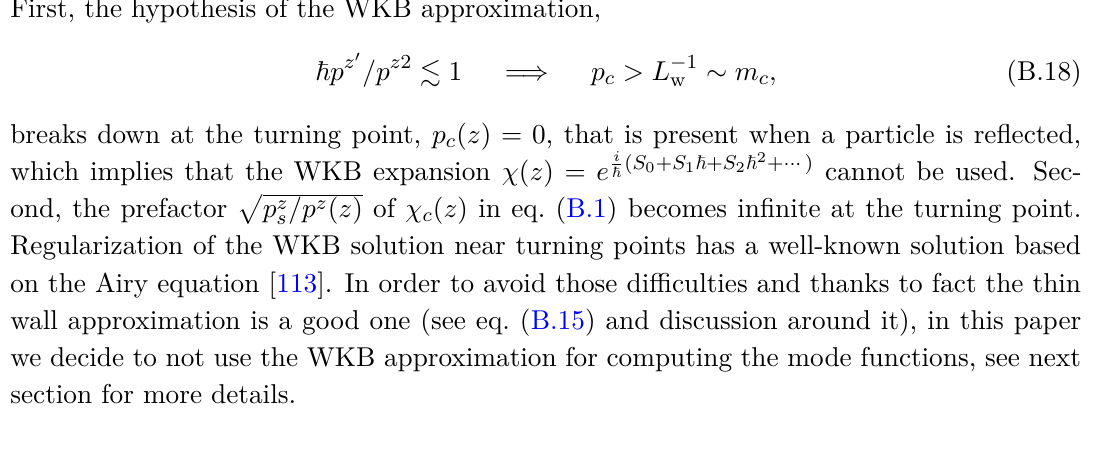
Figure 10 . The exchanged momentum h ∆ p i becomes first logarithmically suppressed when the wall thickness satisfies L w & m − 1 and then exponentially suppressed around L w ∼ m c,h /m 2 c,h lines show the numerically integrated result in eq. (B.13) while dashed lines show the analytical estimate in eq. (B.14). We fix the IR cut-off µ (or equivalently the mass m c,s in the symmetric phase) to the thermal mass α 1 / 2 T nuc in the left panel, see eq. (3.41), and to the screening mass m sat of phase-space-saturated non-abelian vector boson bath, in the right panel, see eq. (3.47). Thin-wall